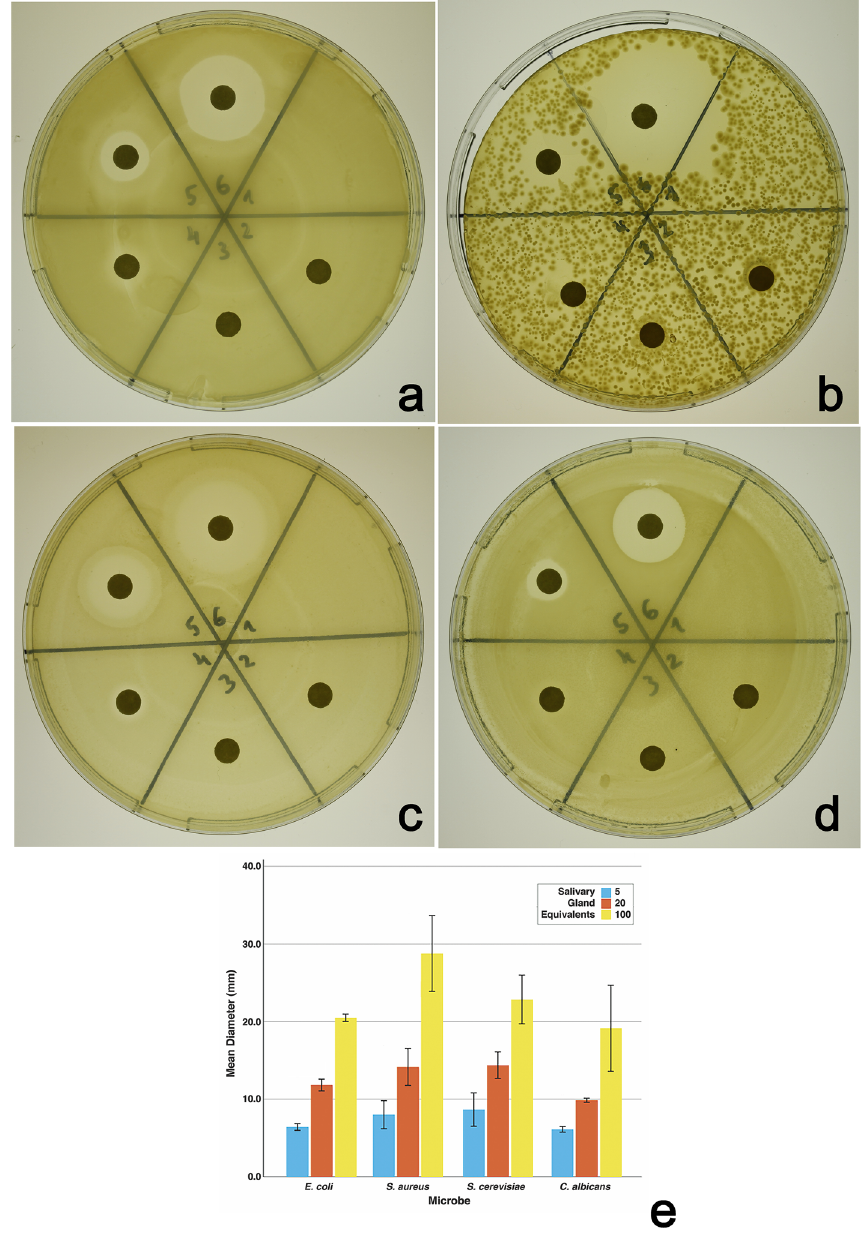
Figure 4. Germicidal properties of the proteinaceous apocrine secretion isolated from the lumen of late prepupal SGs. Apocrine secretion from the equivalent of 5, 20 or 100 wild-type SGs was applied in a 10 μl volume of sterile PBS onto 6-mm diameter Rotilabo filters placed on 10-cm LB-agar ( a,b ) or YPD-agar ( c,d ) plates previously spread with E . coli ( a ), S . aureus ( b ), S . cerevisiae ( c ), or C . albicans ( d ). Sectors 1, 2, and 3 had no filter, an untreated filter, or a filter with only PBS, respectively. Sectors 4, 5, and 6 had filters with the apocrine secretion from the equivalent of 5, 20, or 100 pairs of SGs, respectively. Greater amounts of the apocrine secretion were associated with increased growth inhibition for each microbe tested. Images show data from one representative experiment. The graph shows the mean diameter of growth inhibition, measured using Image J, observed in three replicate experiments (Error bars: 95% CI). There were statistically significant differences in the degree of growth inhibition of each microbe by different amounts of SG extract as determined by one-way ANOVA ( E . coli : F (2,6) = 2788, p = 1.2e−09; S . aureus : F (2,6) = 192.8, p = 3.6e−06; S . cerevisiae : F (2,6) = 162.4, p = 6.0e−06; C . albicans : F (2,6) = 80.6, p = 4.6e−05). For each microbe, post-hoc TukeyHSD tests revealed significant differences (adjusted p < 0.05) in the mean growth inhibition by different amounts of SG extract in all pairwise comparisons. Differences in growth inhibition of Gram-negative ( a ) and Gram-positive ( b ) bacteria may partly reflect differences in culture